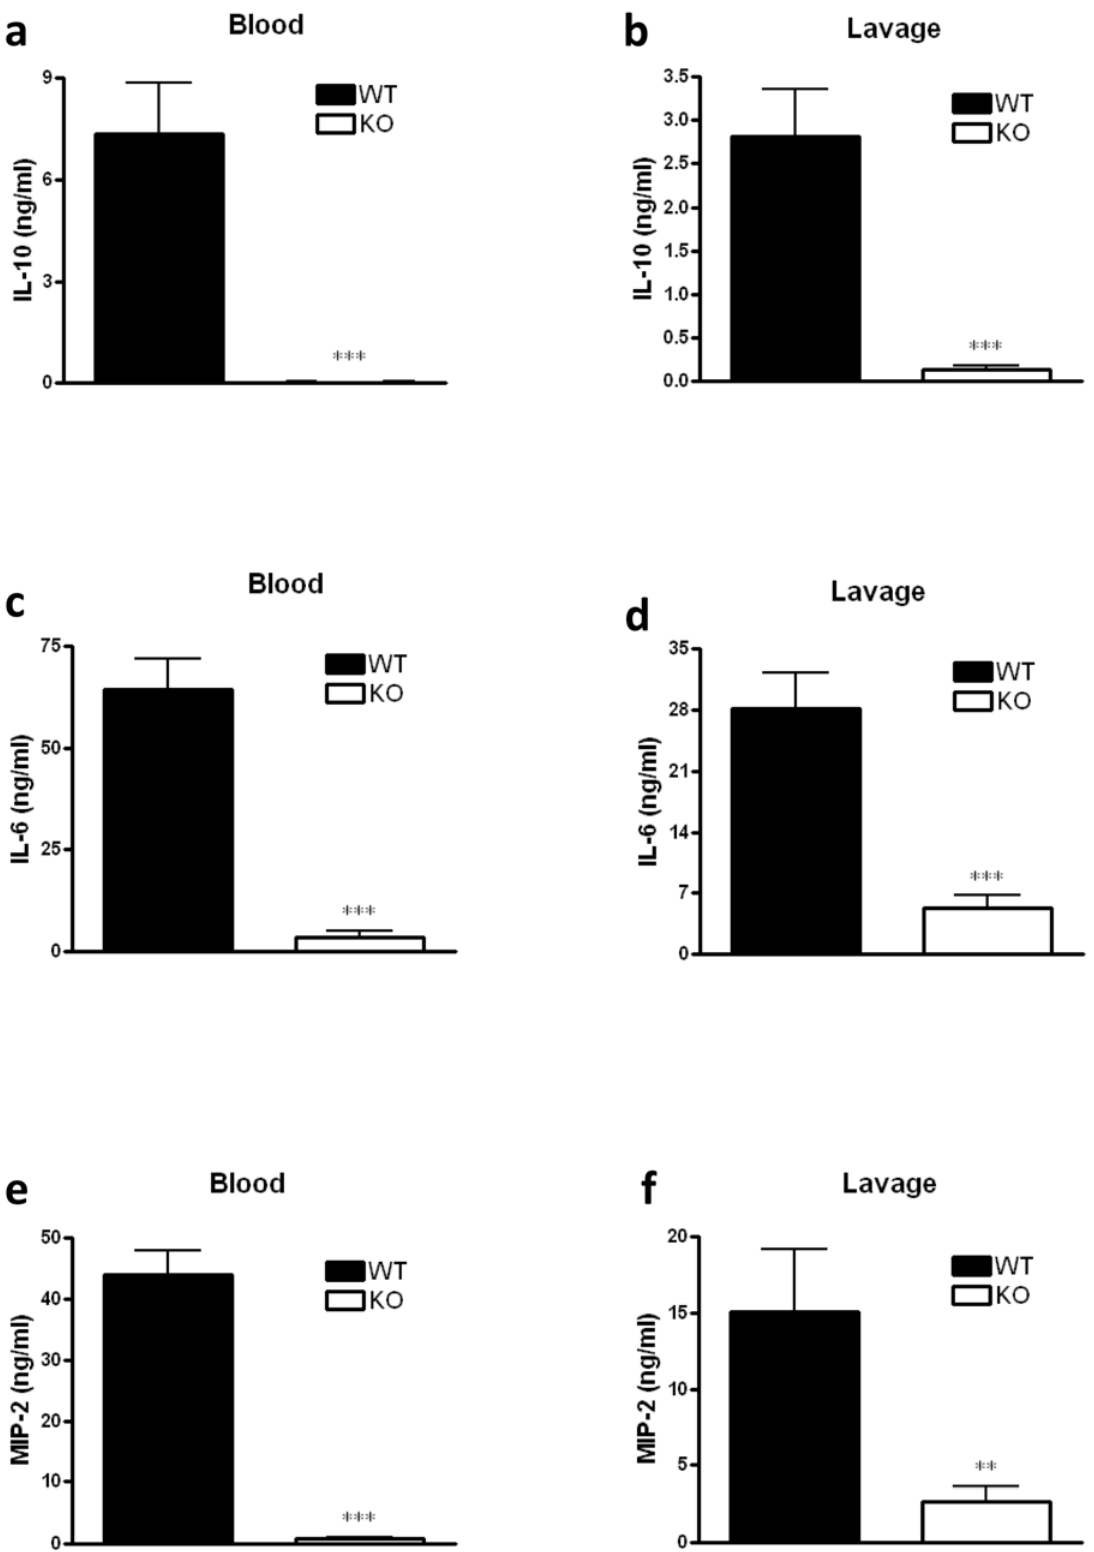
Figure 2. CB 2 receptor deficiency decreases IL-10, IL-6, and MIP-2 levels in the plasma and peritoneal lavage fluid of mice subjected to CLP. IL-10 (a,b), IL-6 (c,d) and MIP-2 (e,f) concentrations were measured at 16 hours after surgery using ELISA. Data are the mean 6 SEM of n =6–9 mice per group. *** p , 0.001; ** p , 0.01.